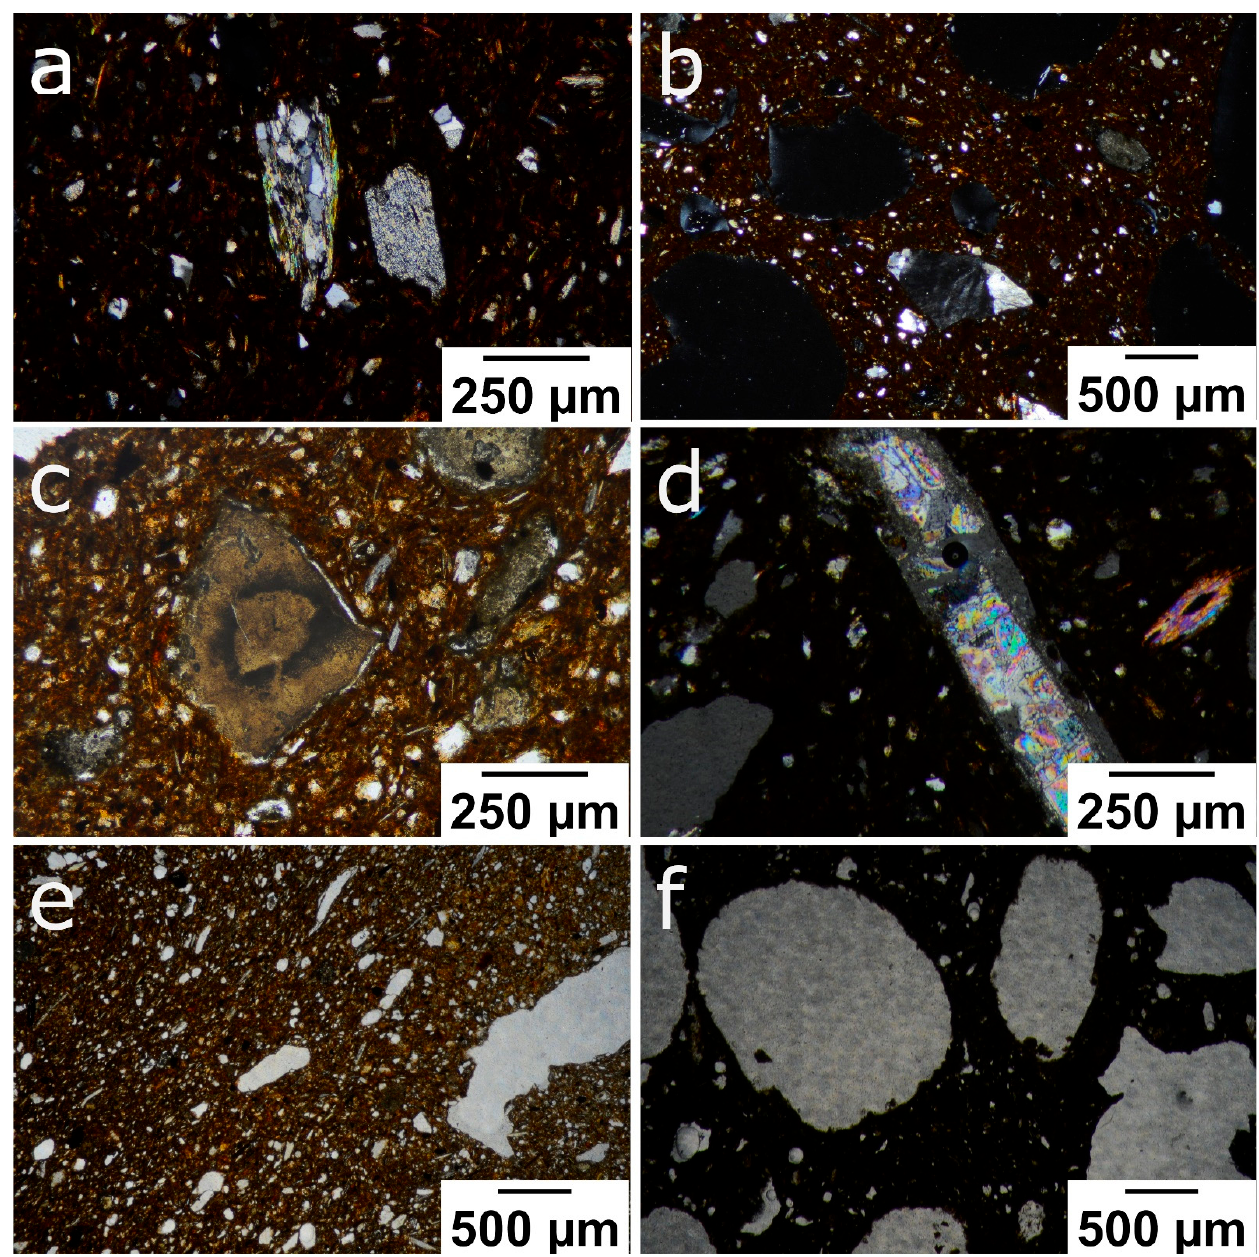
Figure 4. Polarised optical microscope images of the following: ( a ) gneiss fragments and small quartz grains in a brownish matrix (R, PPX); ( b ) feldspar grain and larger rounded pores (P6; PPX); ( c ) decomposed carbonate grain with angular morphology (P2; PPL); ( d ) elongated anhydrite fragment with high interference colour (P6; PPX); ( e ) general view of the porosity of control sample (R, PPL); ( f ) shape of the pores in a brick made with EPS (P6, PPL). Abbreviation: PPL = plane-polarised light; PPX = cross-polarised light.